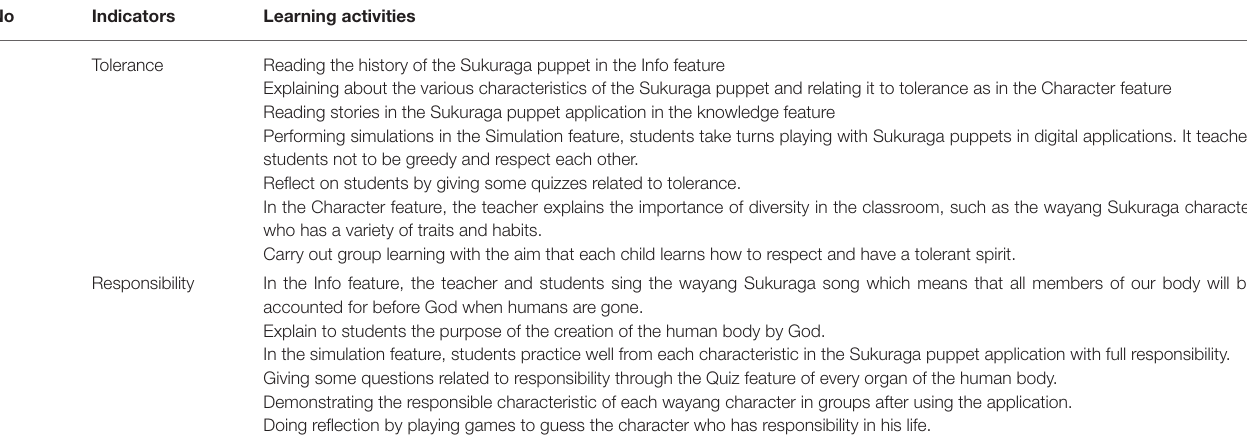
TABLE 1 | Describes the indicators of tolerance and responsibility along with learning activities in the classroom.